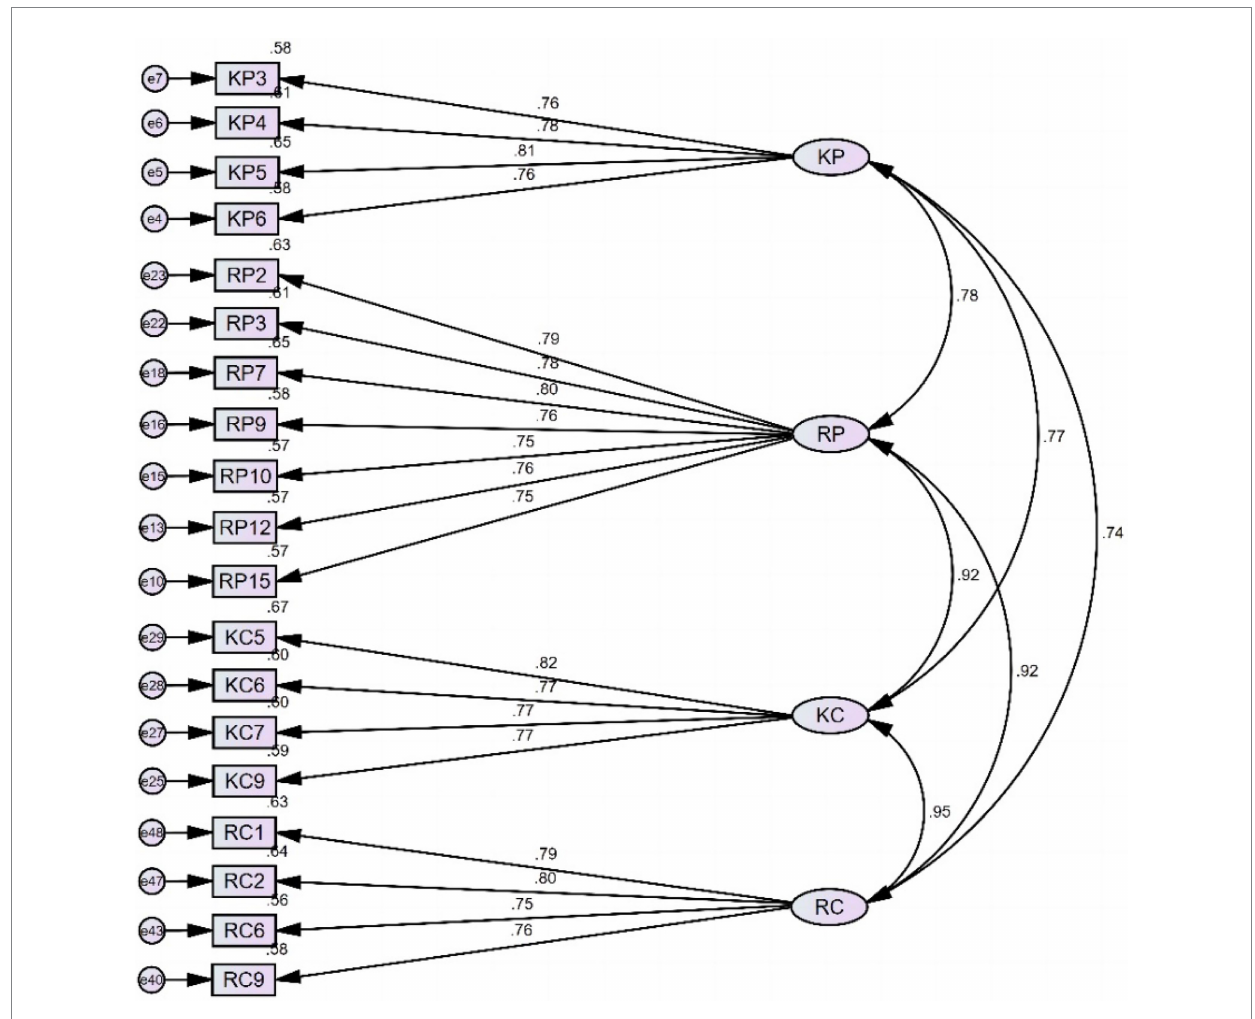
FIGURE 2 Model 2 (with standardized estimates).